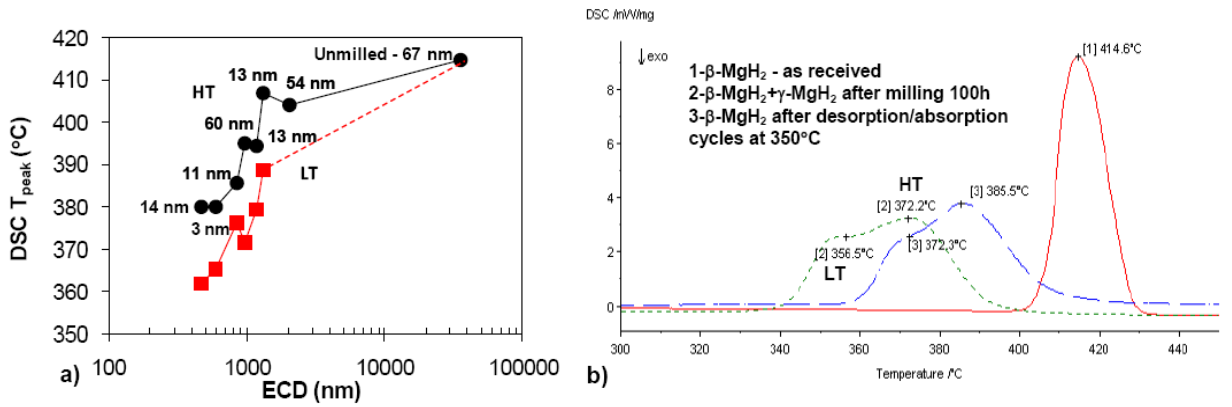
Figure 2. (a) Peak temperature vs. particle size (ECD) for low-temperature (LT) and high-temperature (HT) peak doublets/shoulders for MgH ball milled for various times. A 2 number beside each data point indicates the grain (crystallite) size of the β -MgH phase. 2 (b) DSC curves of the MgH sample ball milled for 100 h (average ECD 621 ± 426 nm; 2 average grain size ~3 nm) and the same after three cycles of desorption/absorption at 350 °C (average ECD 625 ± 405 nm; average grain size ~56 nm) as compared to the DSC curve of as-received commercial MgH (average particle size 36 ± 16.4 μm). DSC heating 2 rate 4 °C/min. ECD-Equivalent Circle Diameter. Adapted from